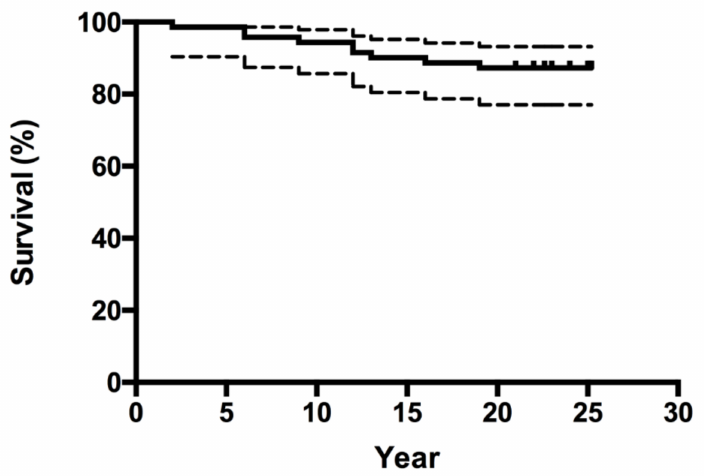
Figure 1. Kaplan–Meier survivorship curve (and corresponding 95% confidence intervals) for all seventy-two hips, with aseptic loosening of the cup as the end